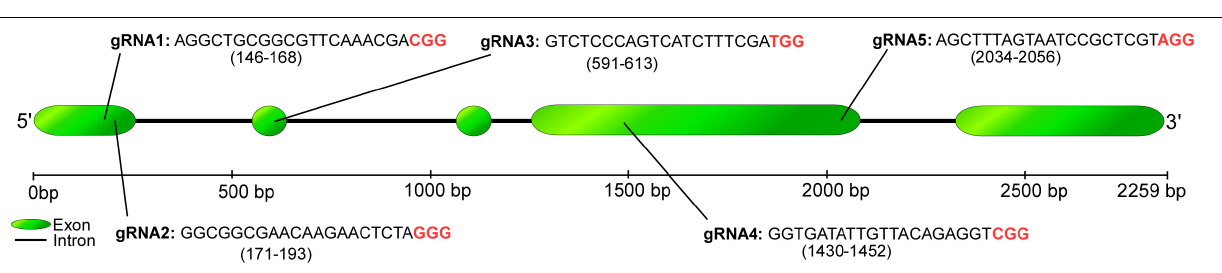
(PAR) of 1,200 lumens/m 2 . Unifoliolate green leaves were used for protoplast